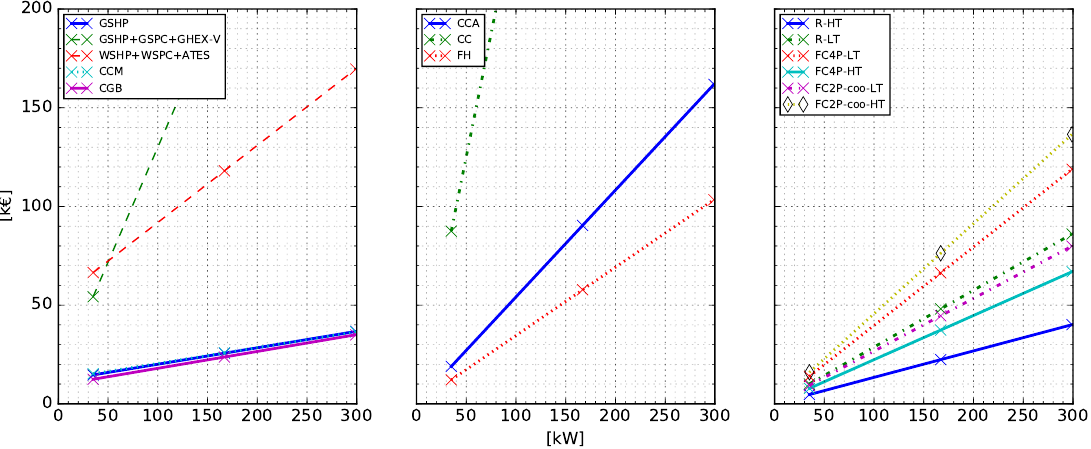
Figure 3. Cost function of each component included in the database. 30 W/m for the borefield and 40 W/m 2 (heating) for Concrete Core Activation (CCA) are assumed to convert the cost function variable to kW. All powers correspond to the nominal heating power of the device, except for FC2P-coo-LT and FC2P-coo-HT for which the nominal cooling power is used instead. The meaning of the legend entries can be found in Table 1.